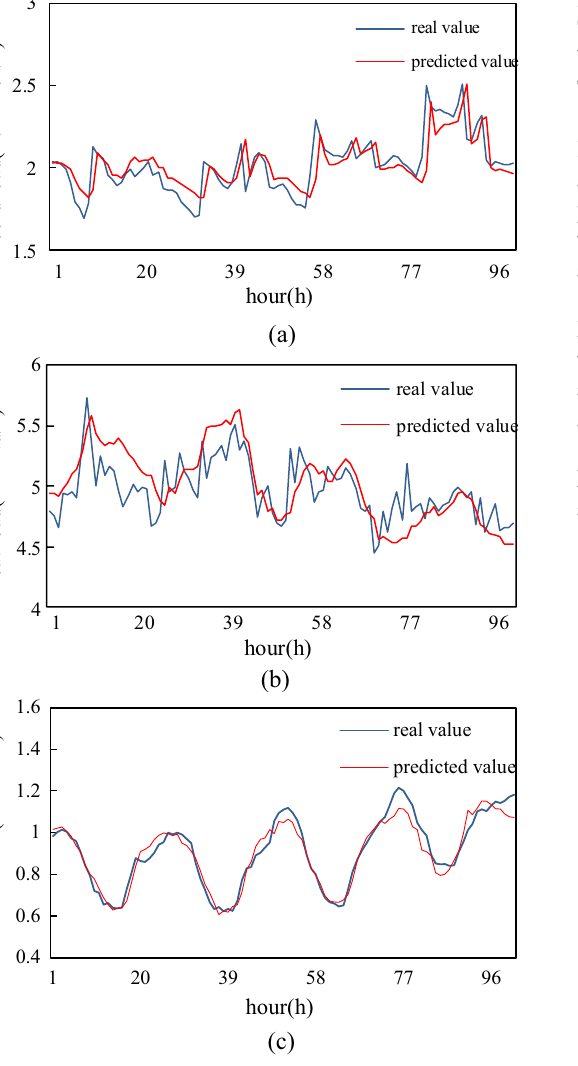
Fig. 5 Prediction results based on CF-LSTM-MTL model. ( a ) Cold load. ( b ) Heat load. ( c ) Electric load